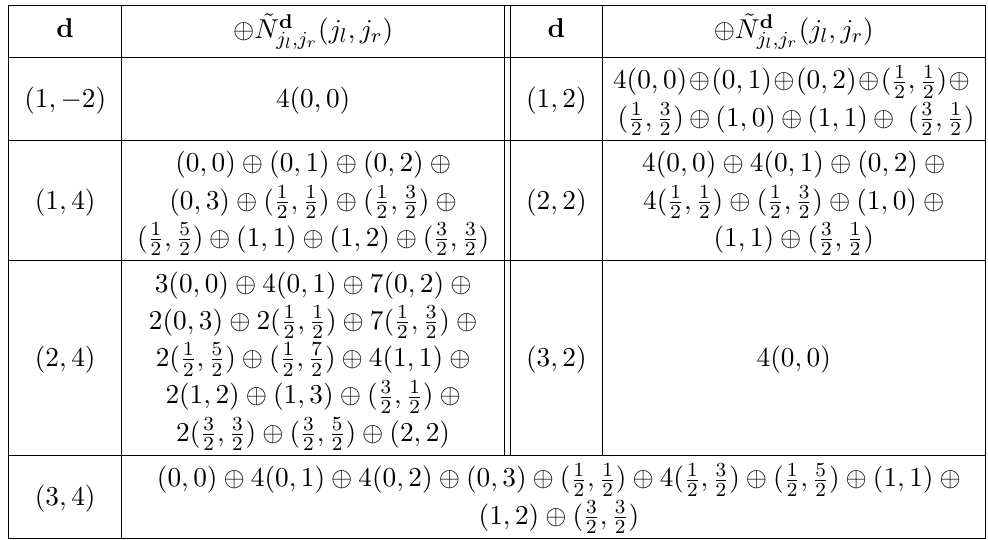
Table 7 . Spectrum of the Wilson loop operator in the rank-4 symmetric representation in the SU(2) 0 theory for d 1 ≤ 3 and d 2 ≤ 5